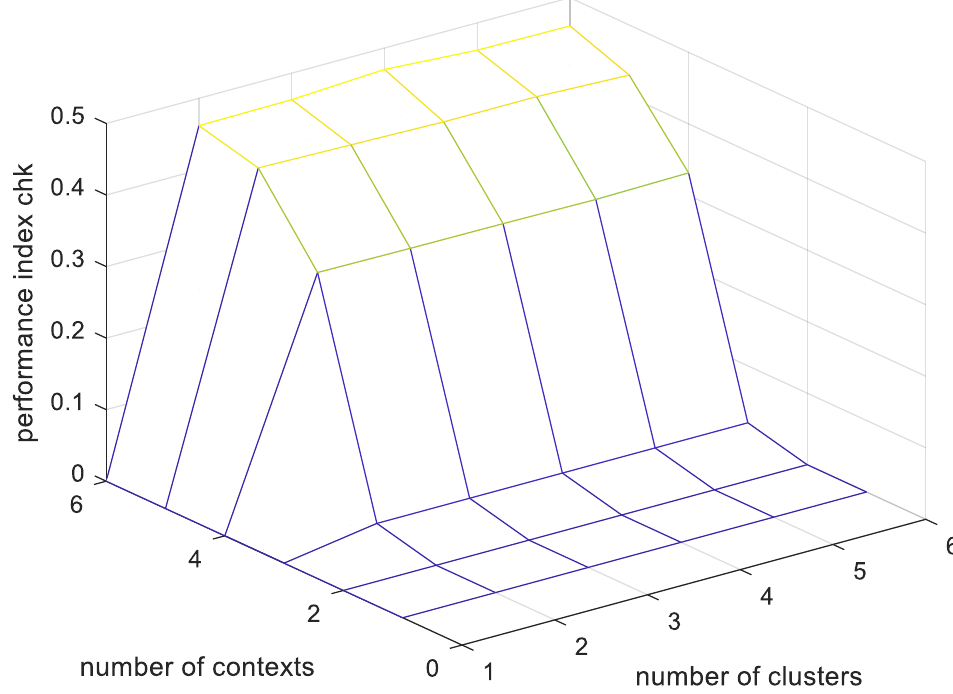
Figure 19. CGK-GM’s performance index for validation data (context equally generated, number of contexts = 6, number of clusters =